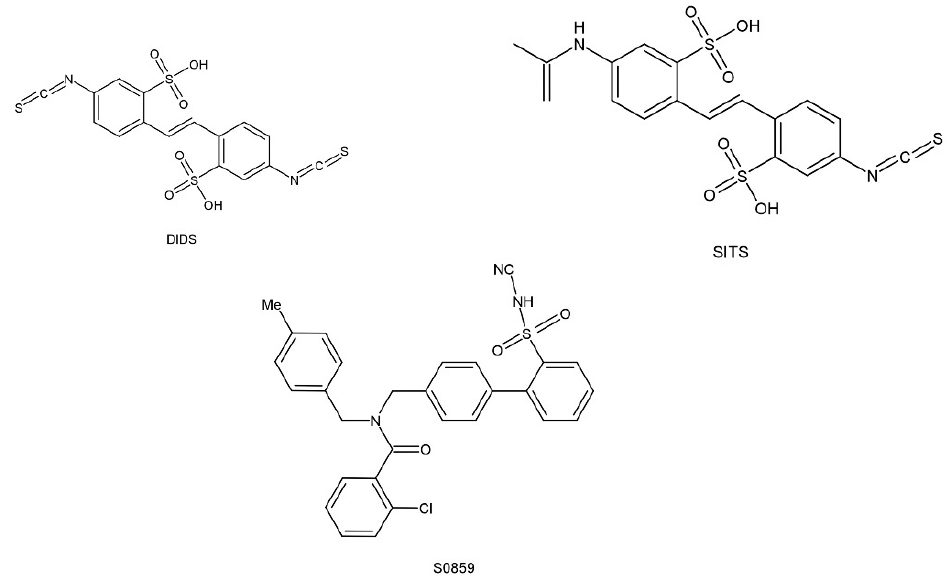
Figure 5. Chemical structural formula of NBCs inhibitor. S0859, an N-cyanosulfonamide compound that acts as a generic NBCs inhibitor, is unable to distinguish between different Na + /HCO 3 − cotransport isoforms but shows significant improvement over stilbene derivatives. The preferred dose of S0859 in vitro was 15 µ M, which provided about 90% inhibition of NBCs activity. Recently, S0859 exhibited inhibition of NBCn1 activity in MCF-7 human breast cancer cell lines [73]. S0859 is selective in acid–base transport in ventricular cardiomyocytes, where it does not impact Cl − /HCO 3 − , Cl − /OH − , or Na + /H + exchange